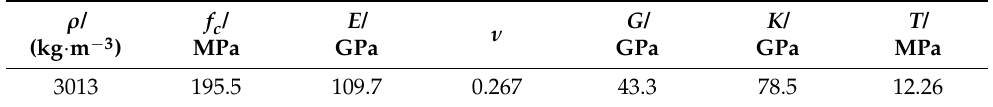
Table 1. The basic physical and mechanical parameters of